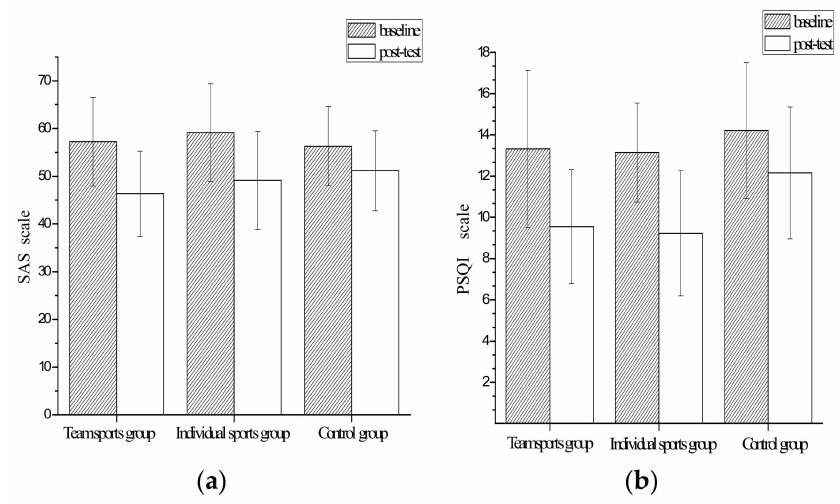
Figure 2. Scores of anxieties and sleep quality in three groups: ( a ) SAS score; ( b ) PSQI